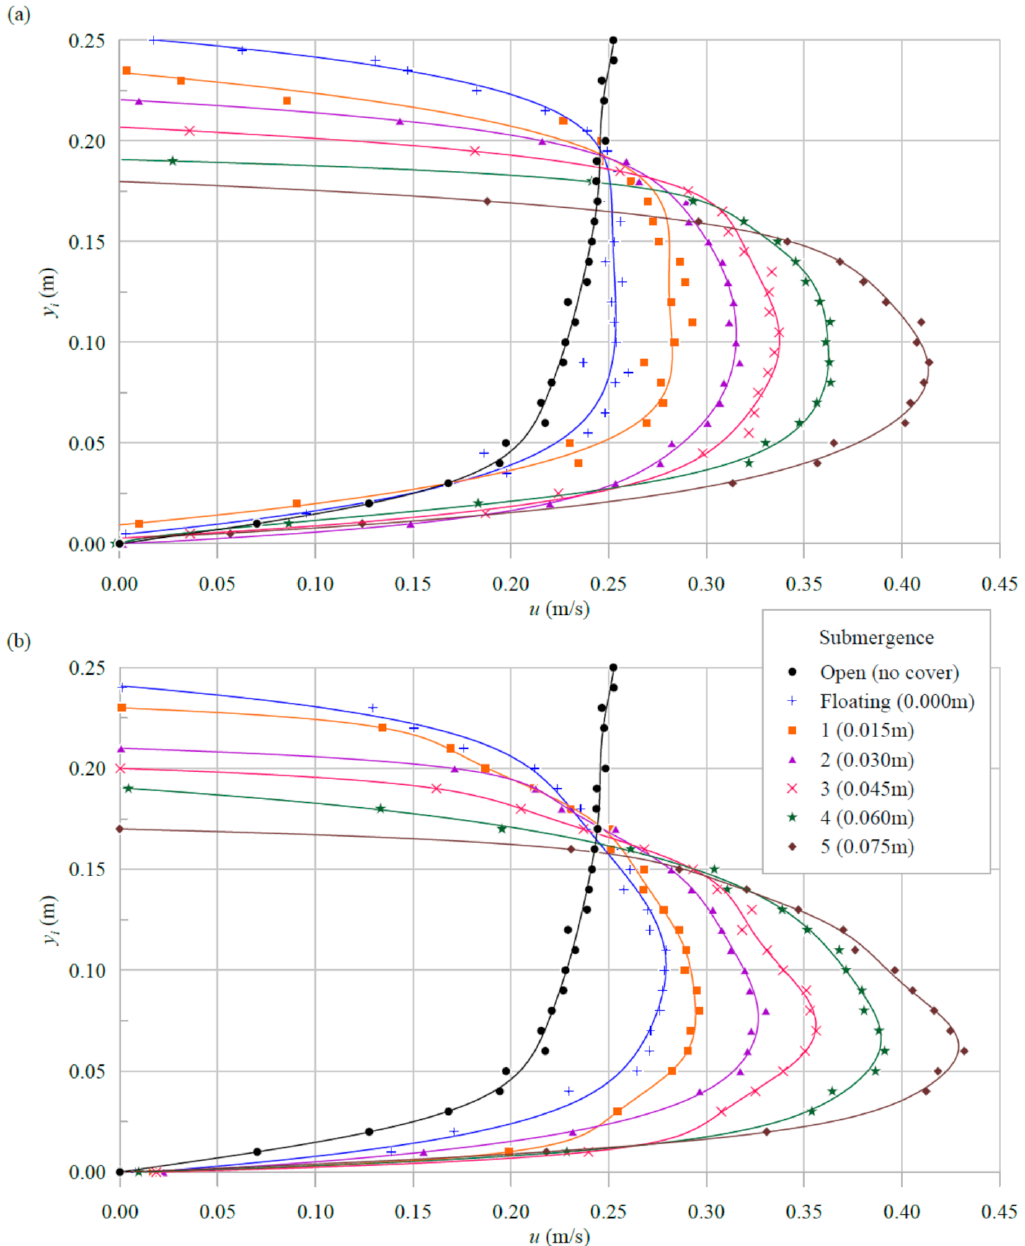
Figure 7. Velocity ( u ) profiles for Open, Floating, and submerged conditions: ( a ) smooth ice cover, and ( b ) rough ice